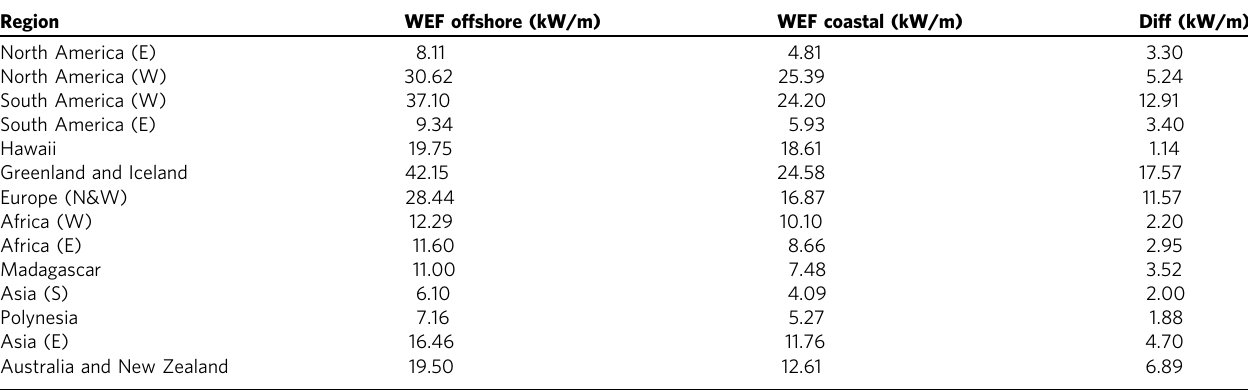
The regional boundaries are reported in Section Subdivision of coastal